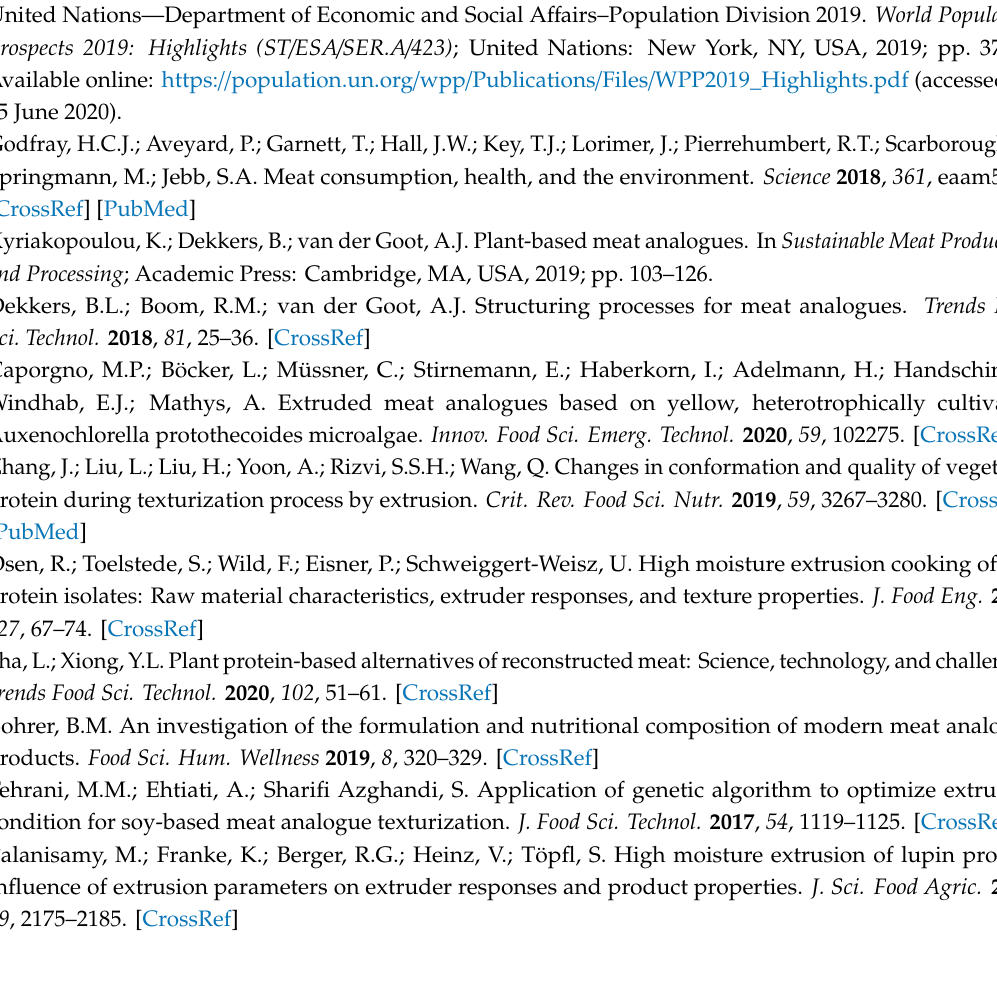
Figure S1: Rehydrated meat analogues produced by low-moisture extrusion cooking. P DF _O P : dry-fractionated pea protein and oat protein; P Is _O P : pea protein isolates and oat protein; P DF _P Is _O P : dry-fractionated pea protein, pea protein isolate, and oat protein; S Is _O P : soy isolates and oat